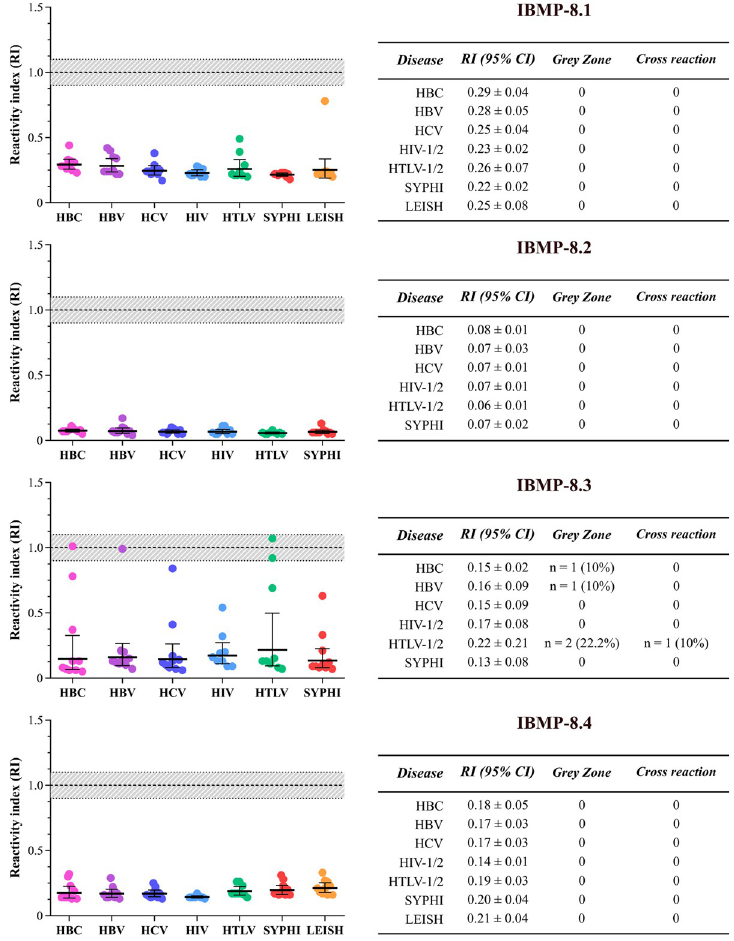
Fig 3. Analysis of cross-reactivity using four Trypanosoma cruzi chimeric proteins in sera from individuals with unrelated infections. Reactivity index (RI) values for each infection are shown via dot-plots with corresponding 95% CI values. The established RI cut-off value was 1.0 (dashed line), with corresponding shaded areas representing grey zones (RI = 1.0 ± 0.10). Solid lines indicate geometric mean RI values and corresponding 95% CI values. HBC (hepatitis B core); HBV (hepatitis B virus); HCV (hepatitis C virus); HIV (human immunodeficiency virus); HTLV (human T-cell lymphotropic virus); SYPHI (syphilis); LEISH (visceral leishmaniasis).